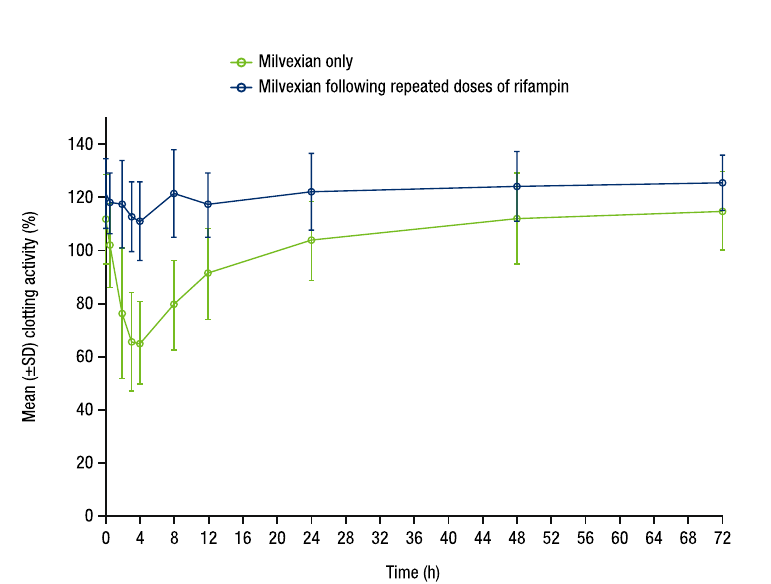
Figure 5. Mean (± SD) FXI clotting activity versus time profile. SD, standard deviation; FXI, factor